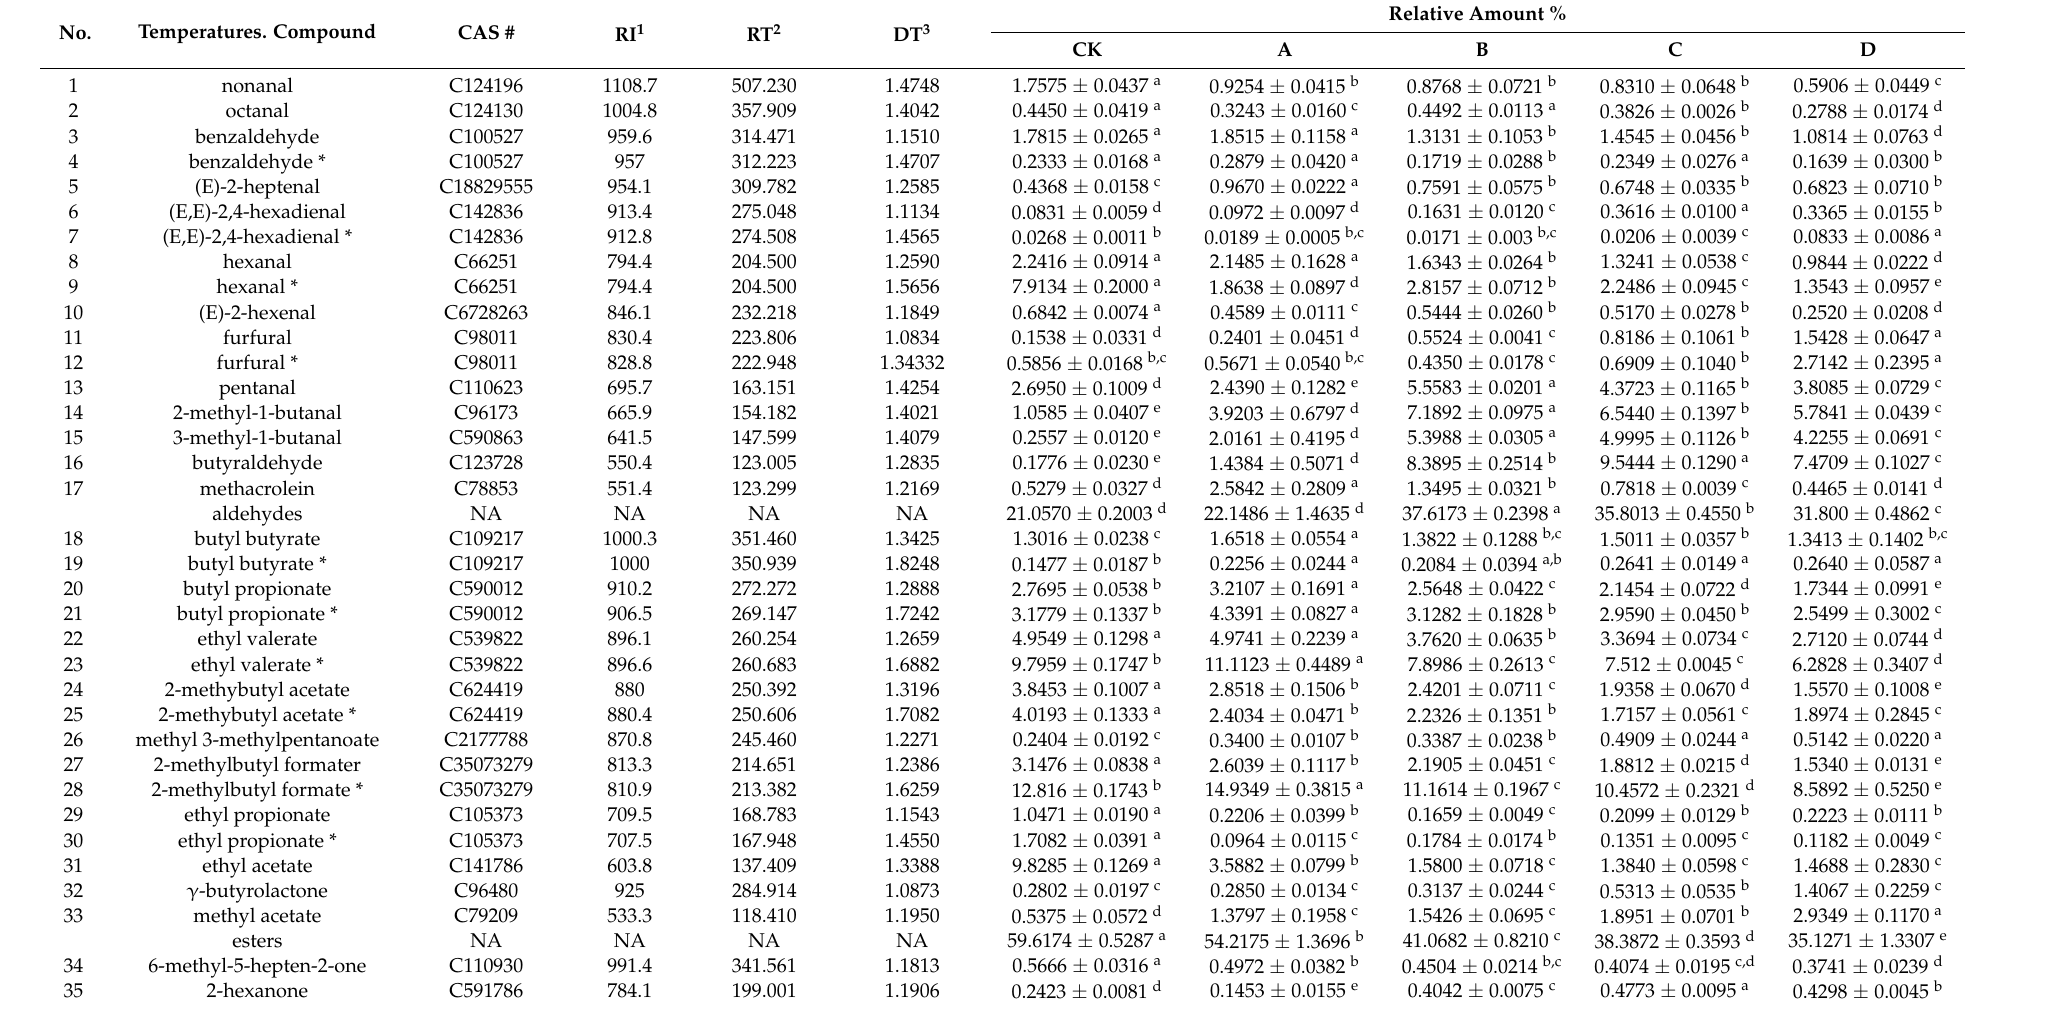
Table 1. HS-GC-IMS integration parameters of pomegranate seeds under different Paozhi processing